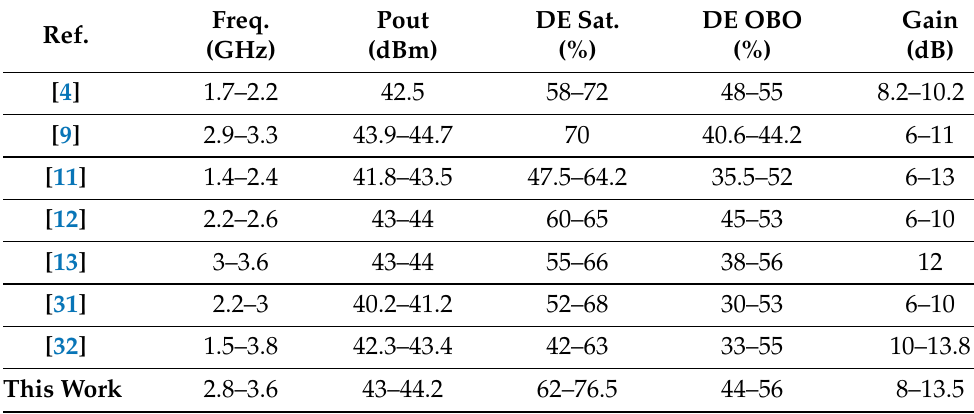
Table 1. Comparison of this work with other designs based on the